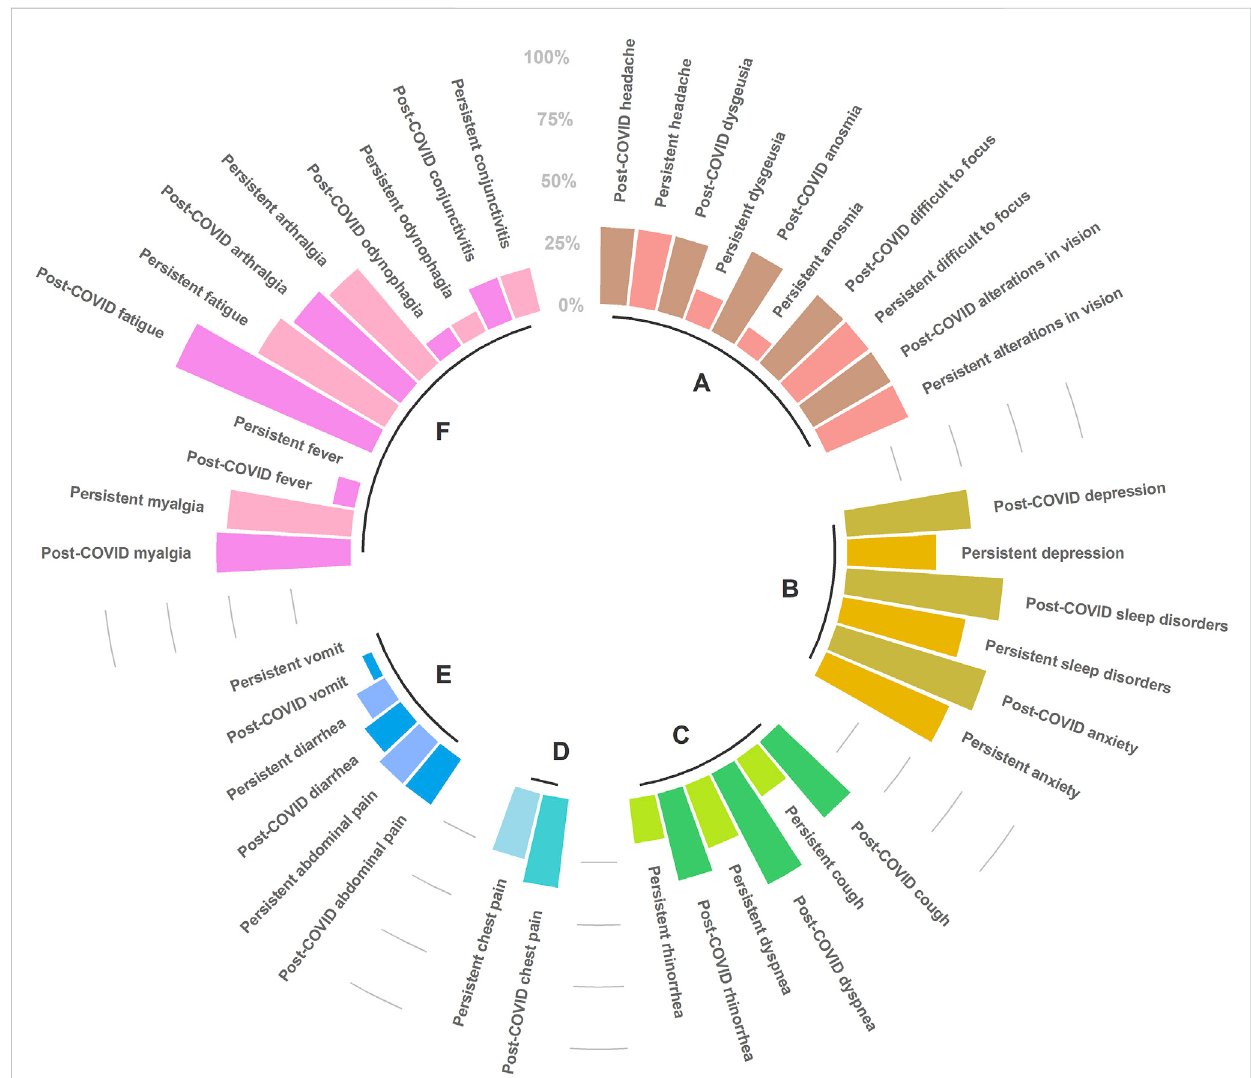
FIGURE 1 Post-COVID-19 (immediately after infection resolution), and persistent symptoms (until September 2022), clustered by etiology condition. (A) Neurological, (B) Psychiatric, (C) Respiratory, (D) Cardiac, (E) Digestive, (F) Systemic.Thescale(0% – 100%)representsthepercentageofpatientsreporting each particular symptom. Figure was built with R package (ggplot2). Only symptoms that were non-signi fi cant (chi 2 test) between post-COVID-19 and persistent status were